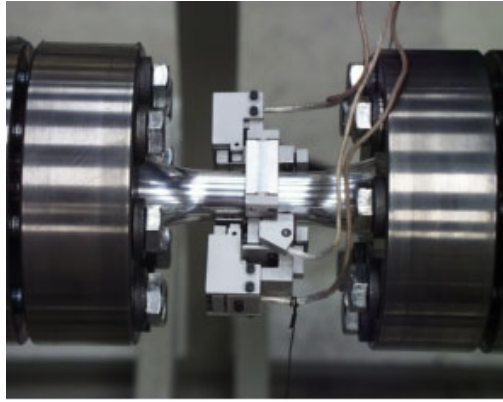
Figure 5. Fatigue test specimen with strain recorder.